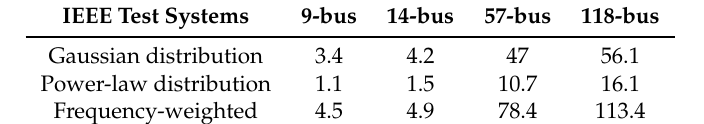
Table 4. K c of three weighted distribution methods in different IEEE systems.